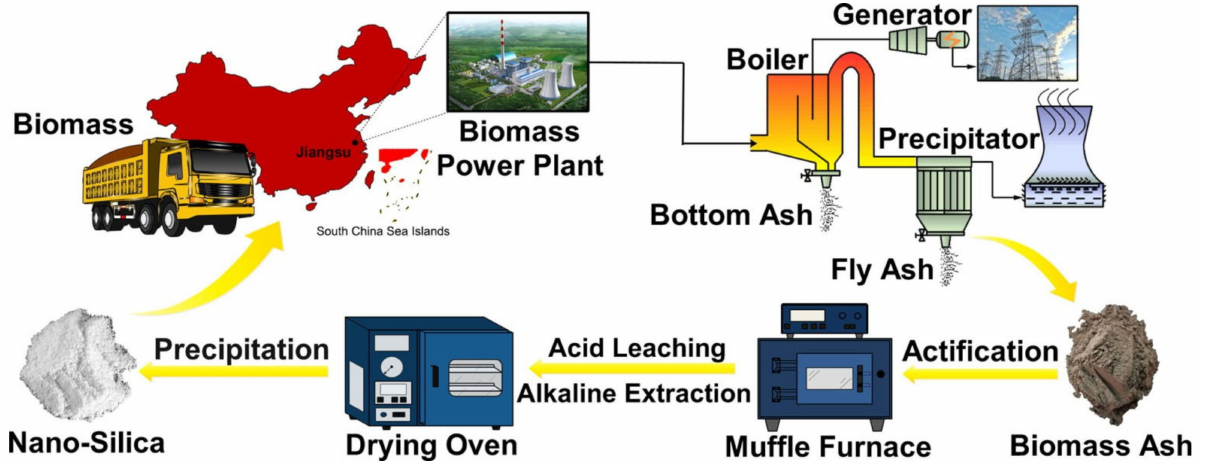
Figure 7. Diagram of clean production of FA (coal → FA) [70]. Reprinted with permission from Elsevier [70].